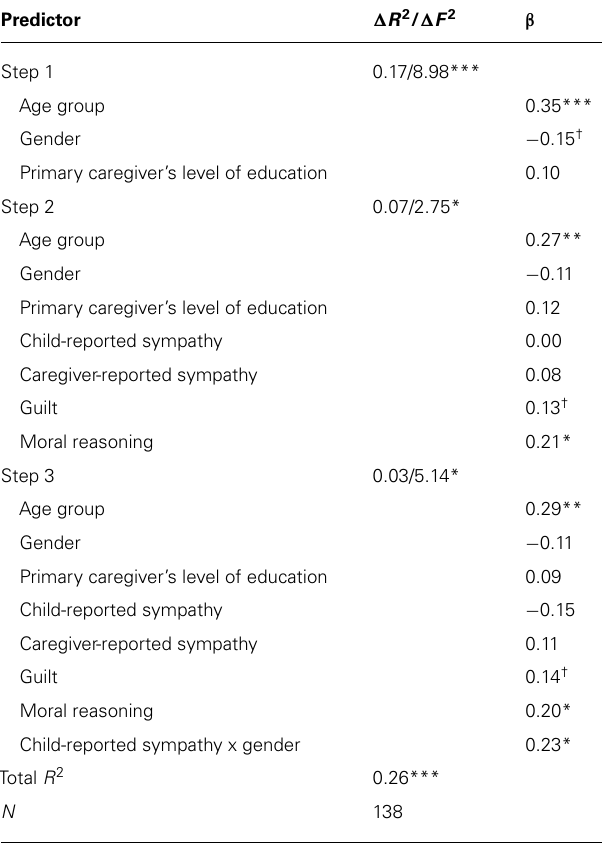
Table 4 | Hierarchical multiple regression analyses predicting children’s donating